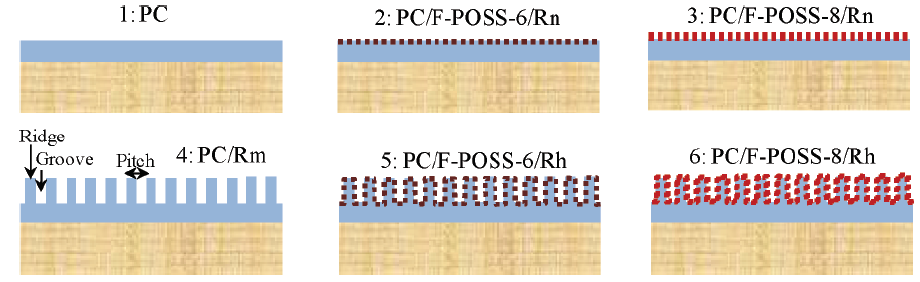
Energies 2016 , 9 , 21